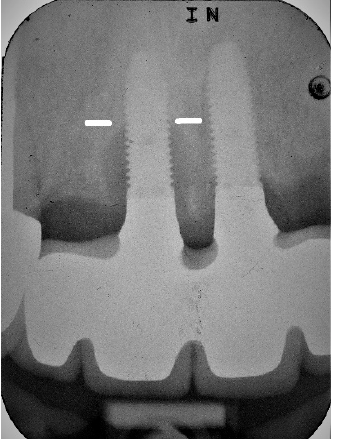
Figure 4. Evaluation periapical radiograph of implant #11 exhibiting further progression of the